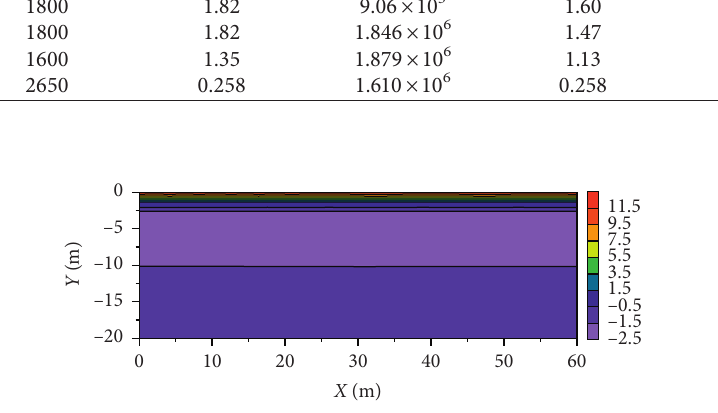
Figure 3: Initial temperature condition of parts II, III, and IV (unit: ° C).